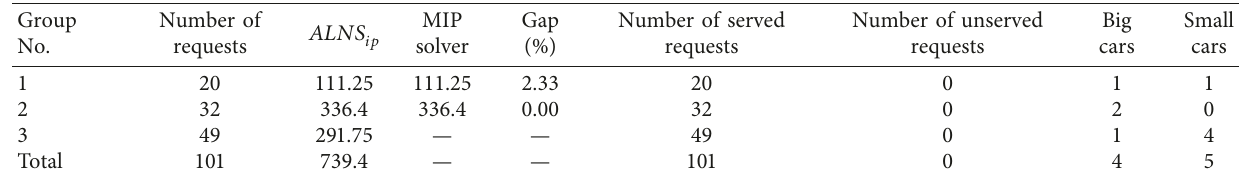
Table 18: Results for 3 Group instances.